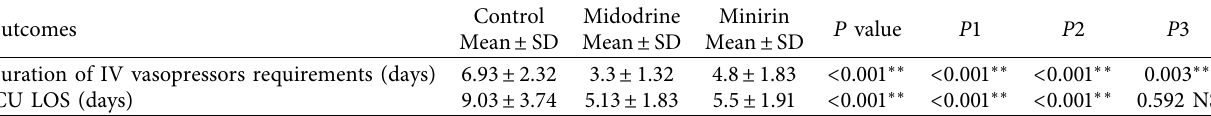
Table 1: Comparison between the three studied groups related to the duration of IV vasopressor requirements and ICU LOS ( n � 90). Outcomes